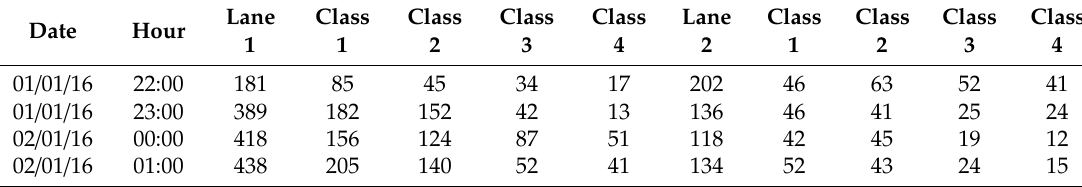
Table 1. Sample data from a generated file for a two-lane road with vehicle classes.